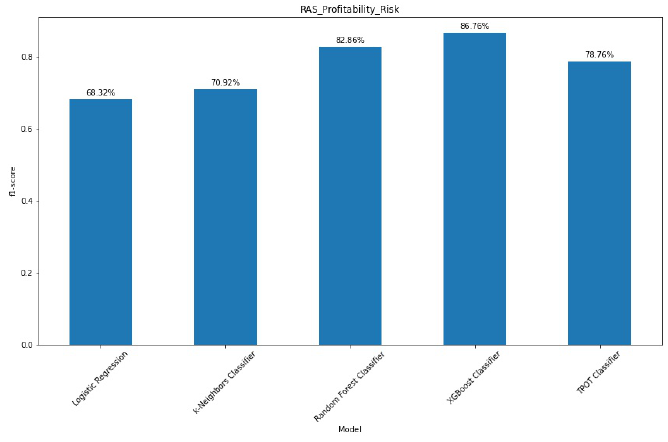
Figure 10. F1-scores of each model, using cross-validation